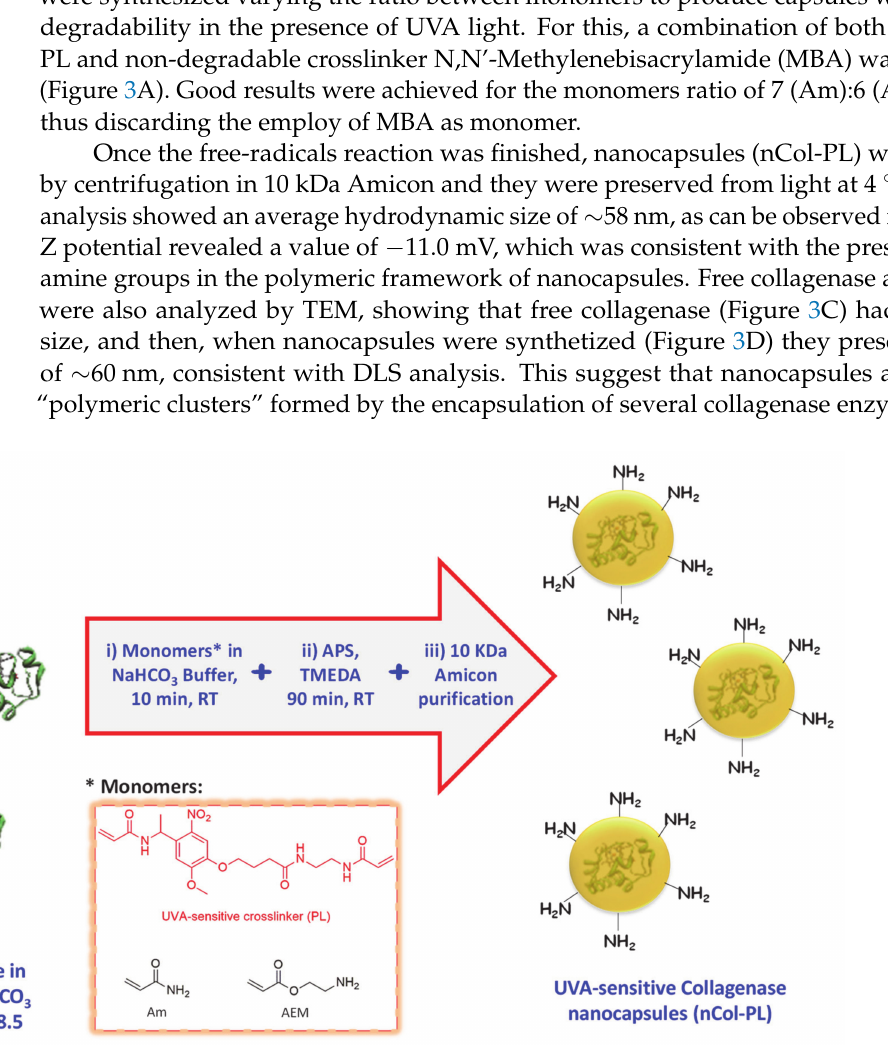
Figure 2. Schematic procedure for UVA-sensitive Collagenase nanocapsules synthesis. Asterisk indicates the monomers employed in the synthetic step